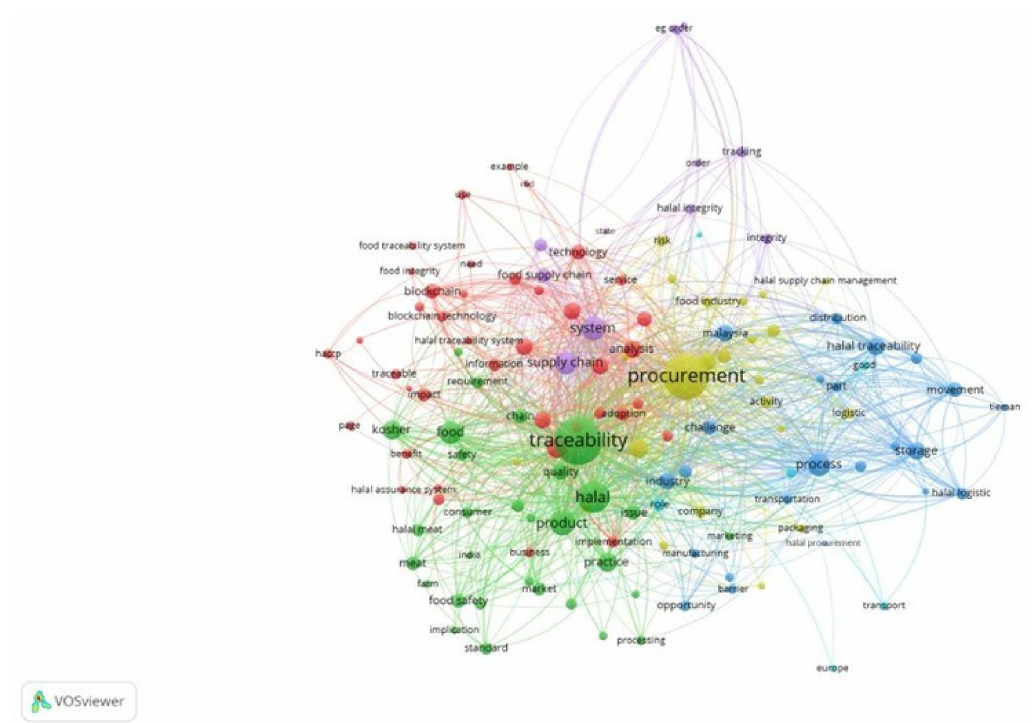
Figure 7. VOSviewer cluster